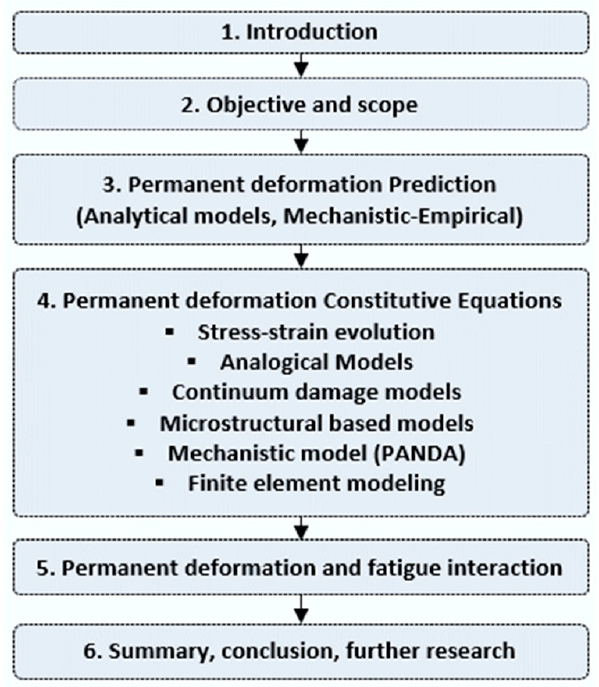
Figure 1. Flow chart of the study structure.